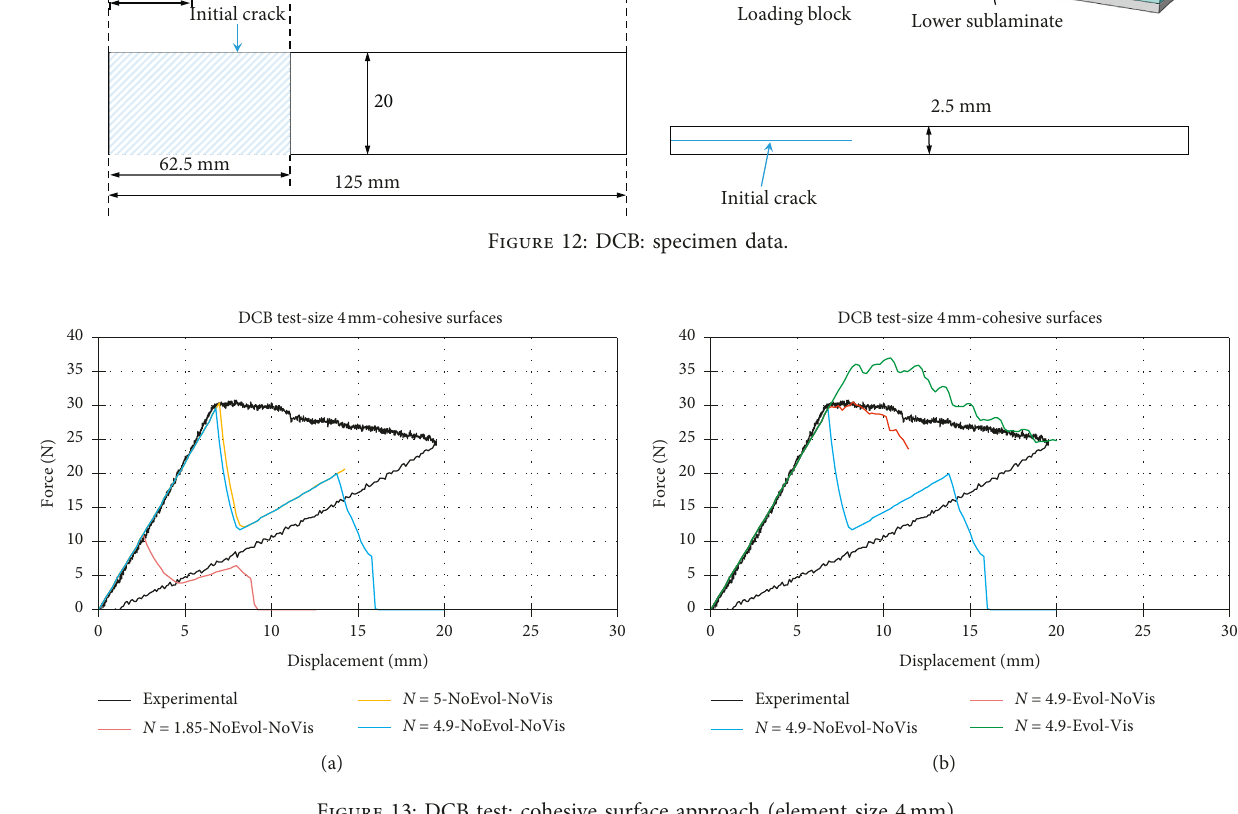
Figure 13: DCB test: cohesive surface approach (element size 4 mm).